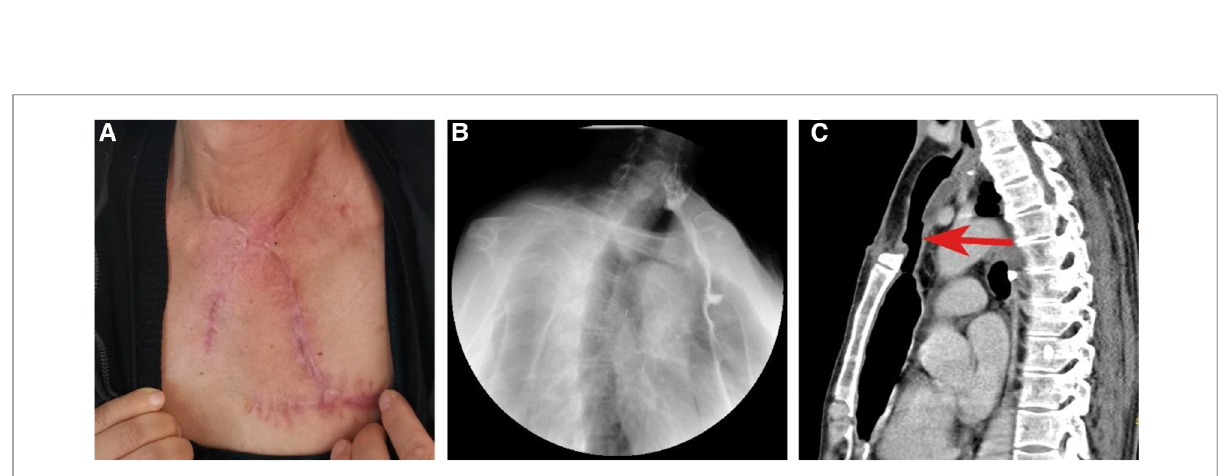
FIGURE 4 Postoperative visual inspection, esophagography and CT scan. ( A ) Postoperative visual inspection of external neck skin. ( B ) Esophagography shows the function of the reconstructed esophagus at the second month postoperatively. ( C ) CT shows the spacious reconstructed esophagus at the second month